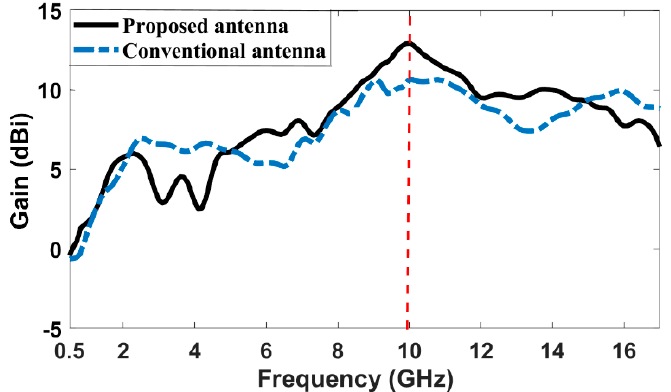
Figure 7. Gain of the AVA structure with arms (proposed antenna) and without arms (conventional antenna).